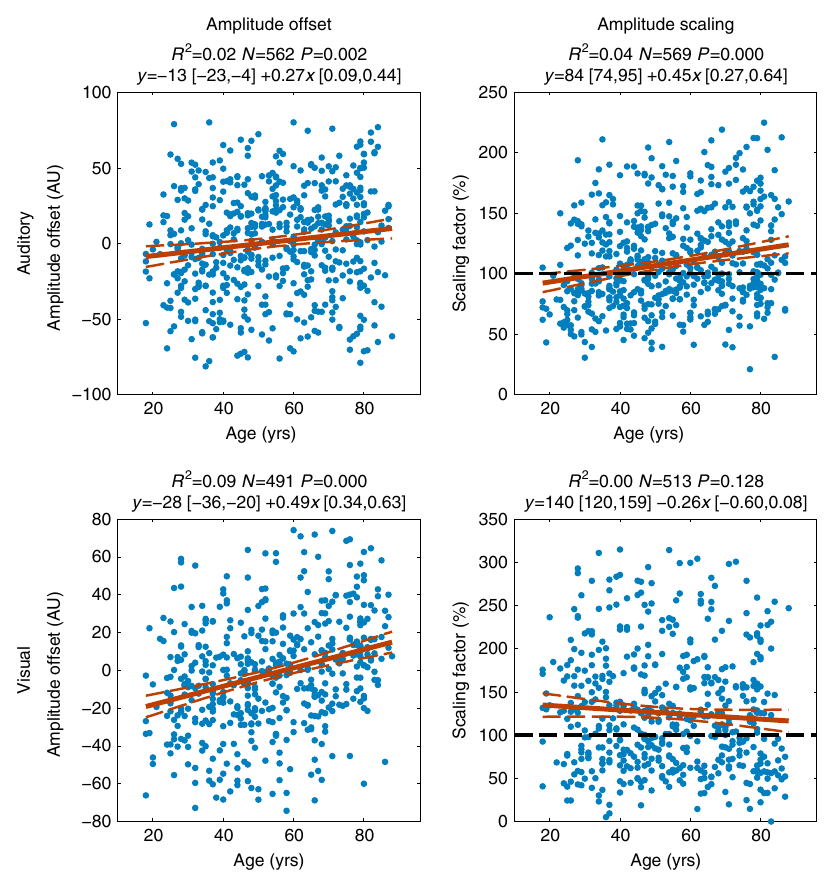
Figure 3 | Amplitude offset and amplitude scaling parameters extracted during template fitting. Amplitude offset was calculated by taking the mean difference between template and individual ERFs, while amplitude scaling indicates the amount the template needs to be scaled to minimize residual error between template and individual ERF. Table 1 | Comparison of ERF fitting results between Passive and Active tasks. Slope: Passive N Slope: Passive – Active Slope: Active r s b [CI] ( R 2 ) b [CI] ( R 2 ) Auditory constant